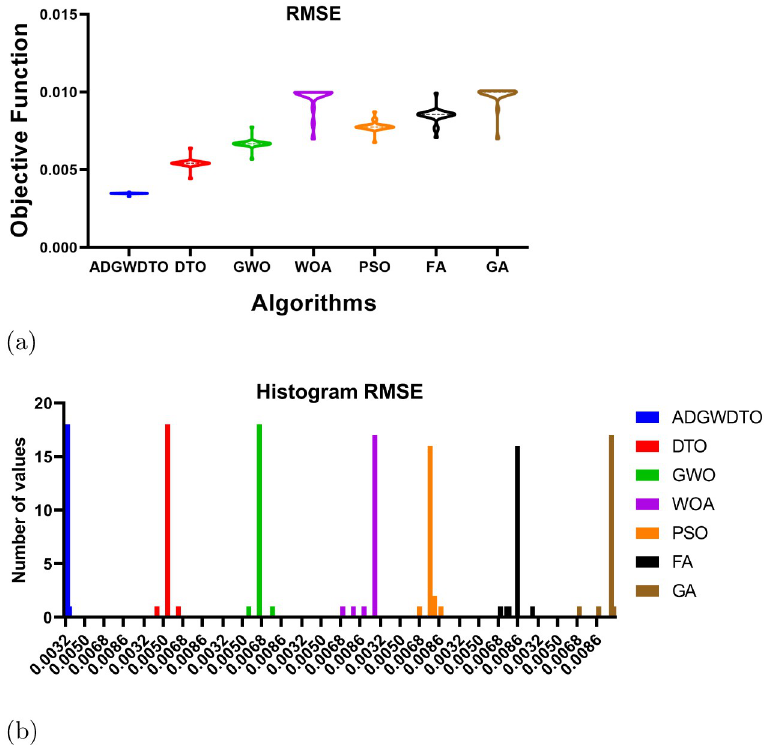
Fig 6. RMSE and Histogram RMSE of ADGWDTO algorithm compared to DTO, GWO, WOA, PSO, FA, and GA algorithms.